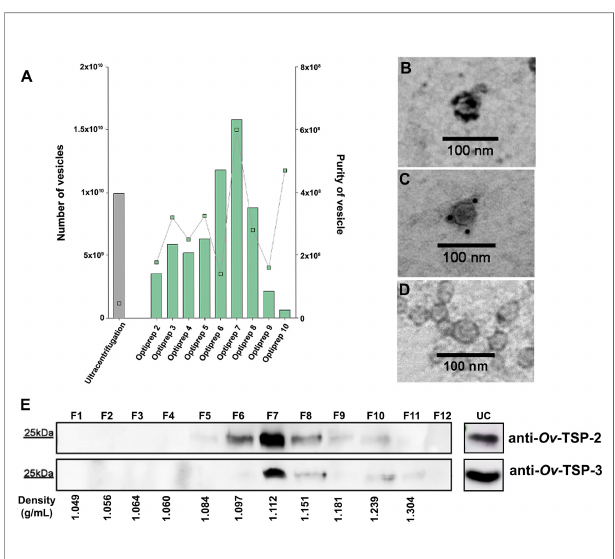
FIGURE 1 | Characterisation of Opisthorchis viverrini 120k extracellular vesicles. Opisthorchis viverrini 120k extracellular vesicles (EVs) EVs were puri fi ed by Optiprep density gradient and quanti fi ed by tunable resistive pulse sensing using a qNano instrument (A) . Characterization of 120k EVs